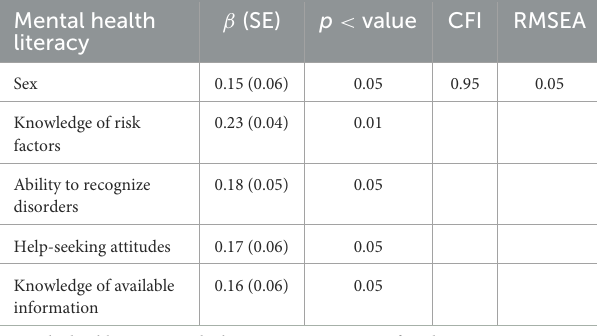
TABLE 2 Univariable regression model of the unique influence of different domains of mental health literacy and total mental health literacy on depression based on a continuous scale.